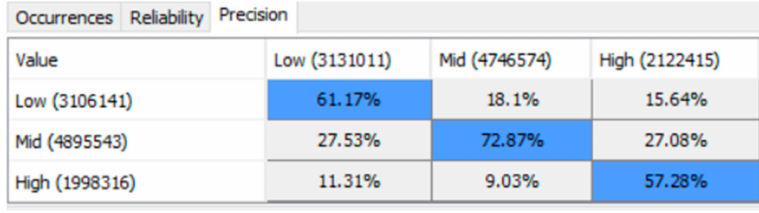
Figure 25. Precision confusion matrix after performing target evaluation cross-validation by bootstrapping the data in each node 100,000